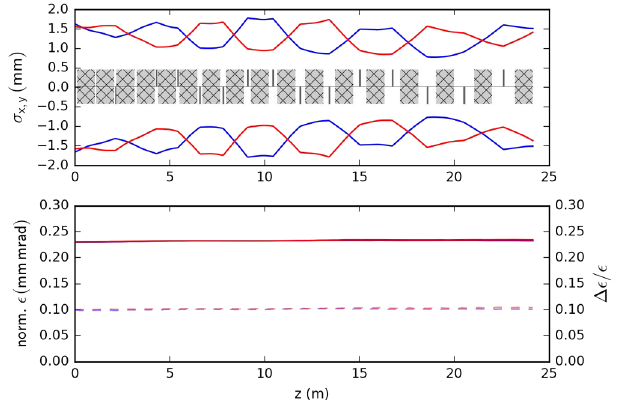
FIG. 7. rms beam envelope for the second pass using 6D Gaussian initial distribution with 20 mA bunch